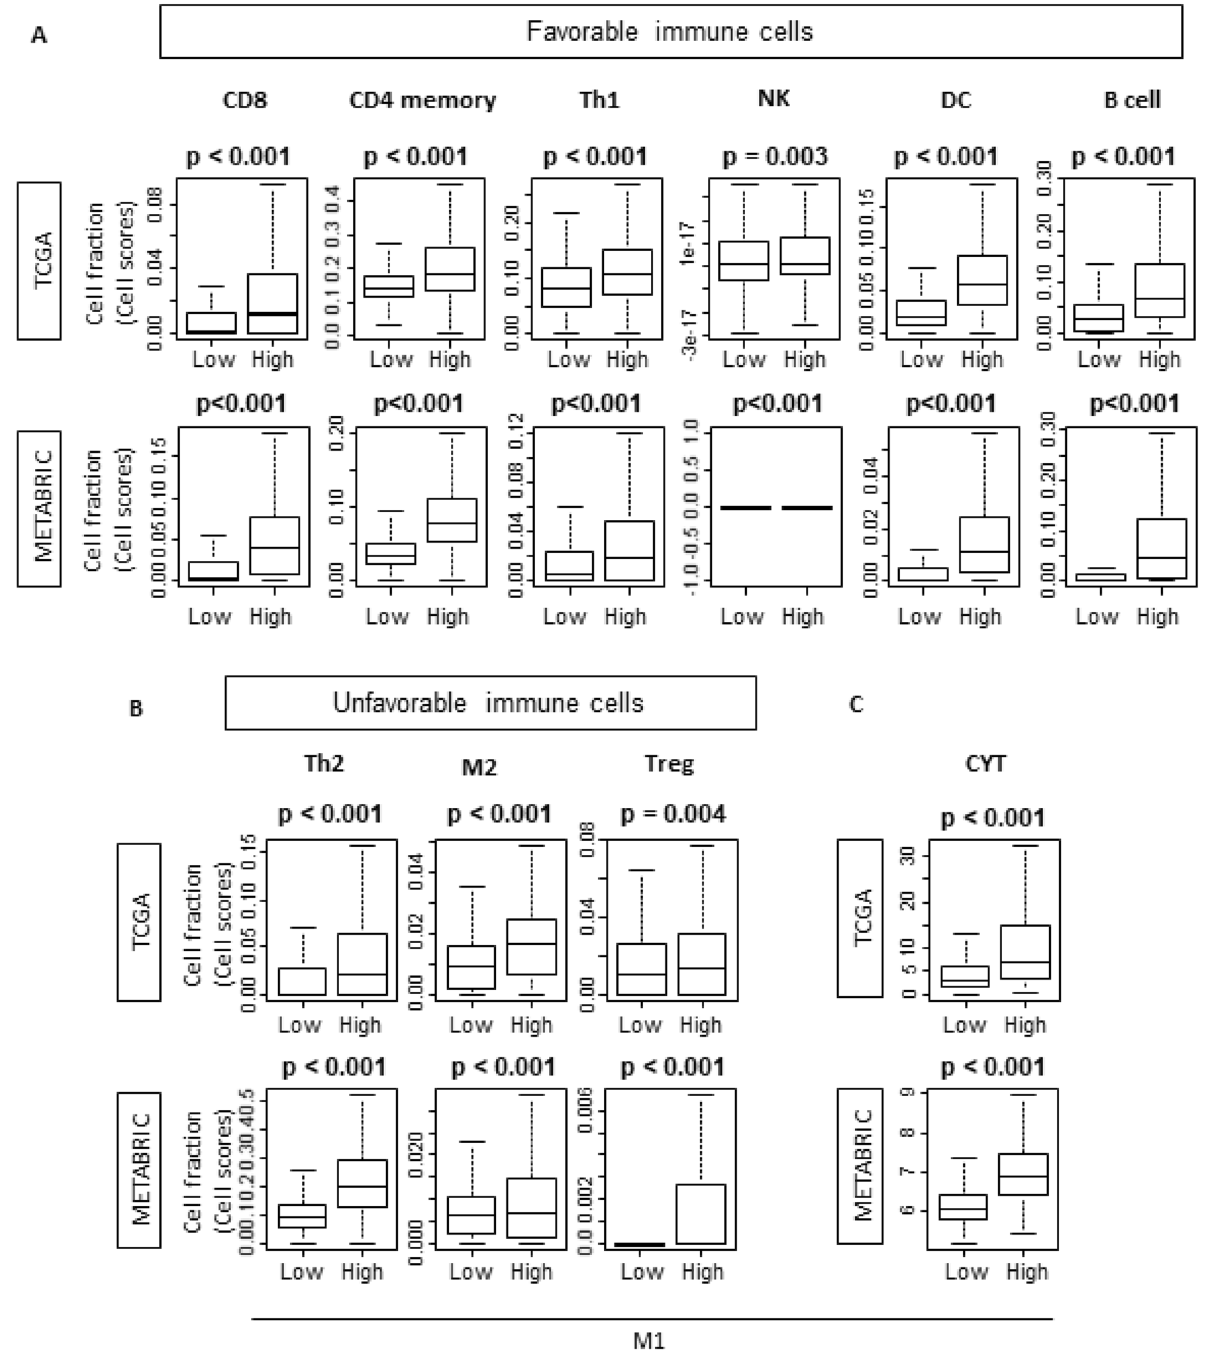
Figure 6. “M1” high tumors demonstrated the infiltration of both favorable and unfavorable immune cells in TCGA and METABRIC cohort. T-helper 1/2; DC, Dendritic Cell; Treg, regulatory T cell; CYT, cytolytic activity score. TCGA (n = 1065, High = 533, Low = 532). METABRIC (n = 1903, High = 953, Low =